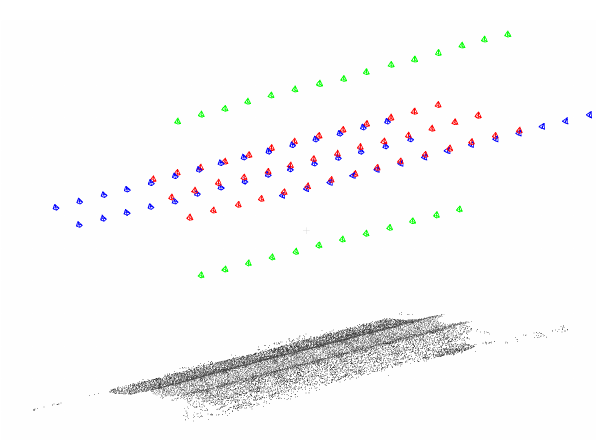
Figure 1. Illustration of flights: nadir flight of 3 strips at 50m (in red), oblique flight of 3 strips at 50m (in blue) and nadir flights of 1 strip at 30 / 70m (in green).